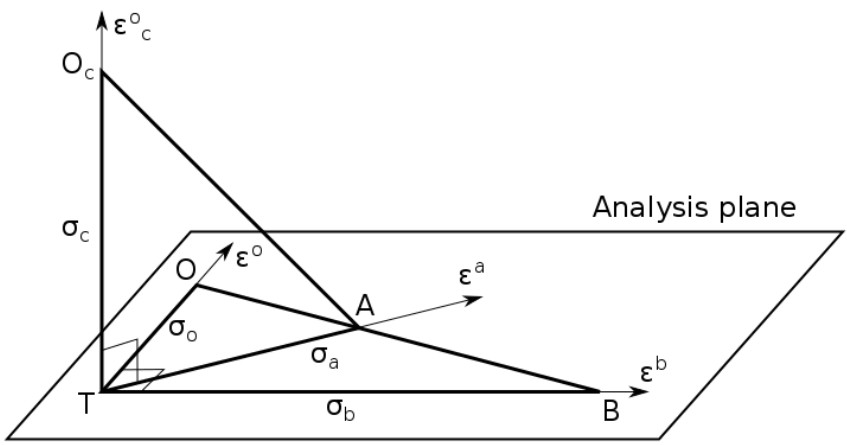
Figure 1. Hilbert space representation of a scalar analysis and cross-validation problem. The arrows indicate the directions of variability of the random variables, and the plane defined by the background and observation errors ε b , ε o defines the analysis plane. The thick lines represent the norm associated with the different random variables. T indicate the truth, O the active observation, B the background, A the analysis and O c the passive observation.